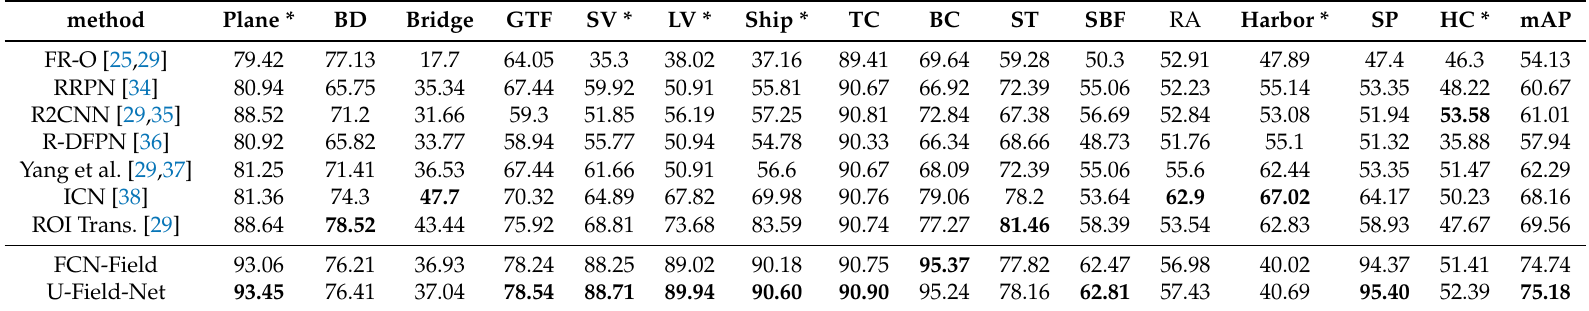
Table 5. Comparisons with state-of-the-art detectors on DOTA [25]. The short names for each category can be found in Reference [29]. The object class marked with * has a directional attribute, that is w c = 1 in the Equation (6). Selective regression of the directional fields of these categories can significantly improve